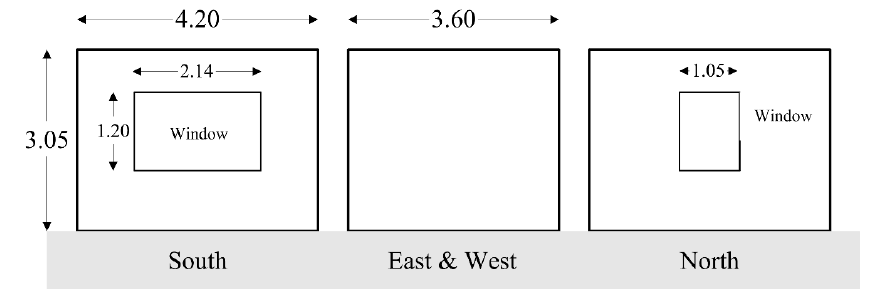
Figure 4. Test module for collecting datasets of the ANN model (in meters). Table 1. Features of the test building.